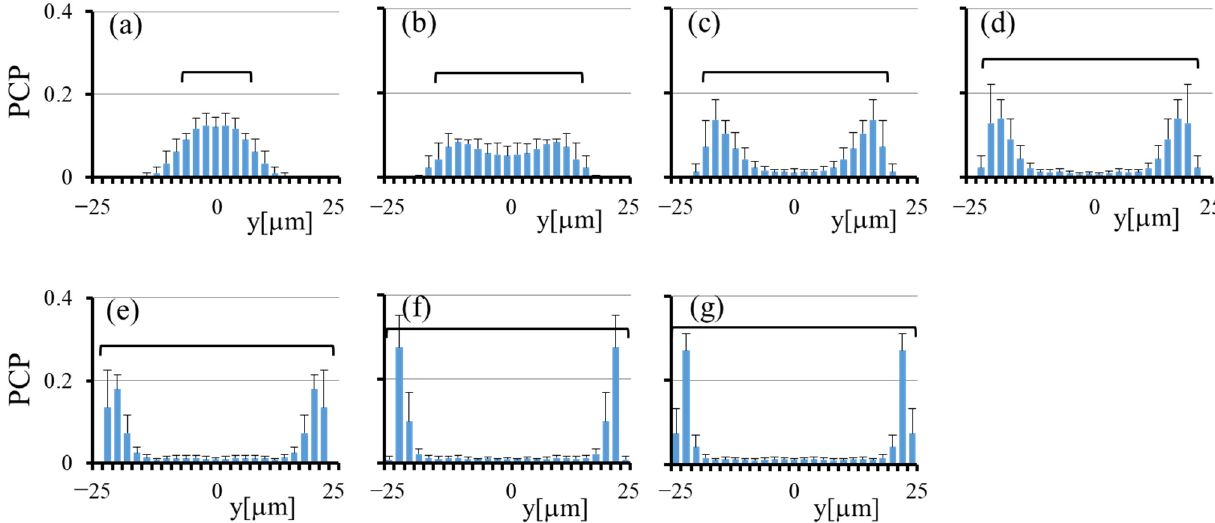
Figure 6. Particle concentration profiles across the channel width in the circular channel at Ht = 20%, ( a ) z =1 µ m, ( b ) z = 5 µ m, ( c ) z = 9 µ m, ( d ) z = 13 µ m, ( e ) z = 17 µ m, ( f ) z = 21 µ m, and ( g ) z = 25 µ m. The histogram represents the average value and standard deviation ( n = 5).